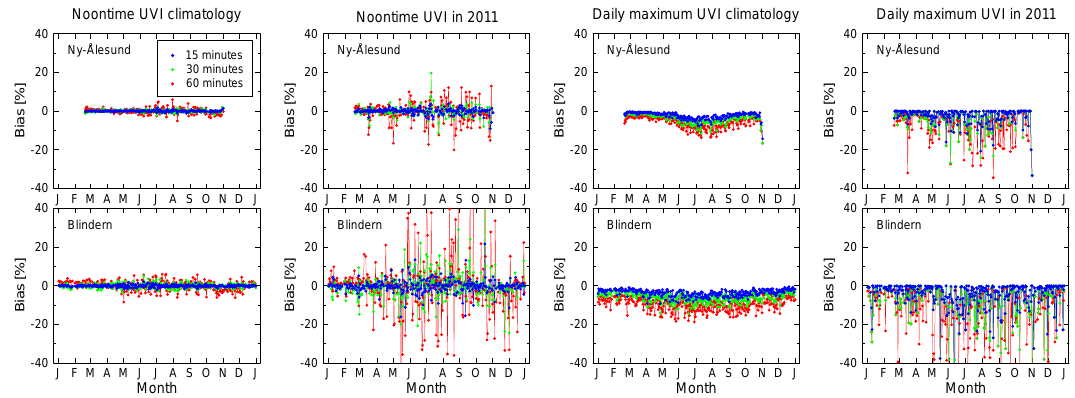
Fig. 2. Bias of subsampled data relative to the native 1-minute data for Ny-Ålesund (top) and Blindern (bottom). Data subsampled in 15, 30 and 60min intervals are shown in blue, green, and red, respectively. Panels from the left to right show the bias for the noontime UVI climatology, the noontime UVI in 2011, the daily maximum UVI climatology, and the daily maximum UVI in 2011. Table 2. Effect of subsampling. Numbers indicate the average bias ± standard deviation in percent for subsampling at 15, 30, and 60min, calculated from all days of the year (DOY 1–365). Subsampling